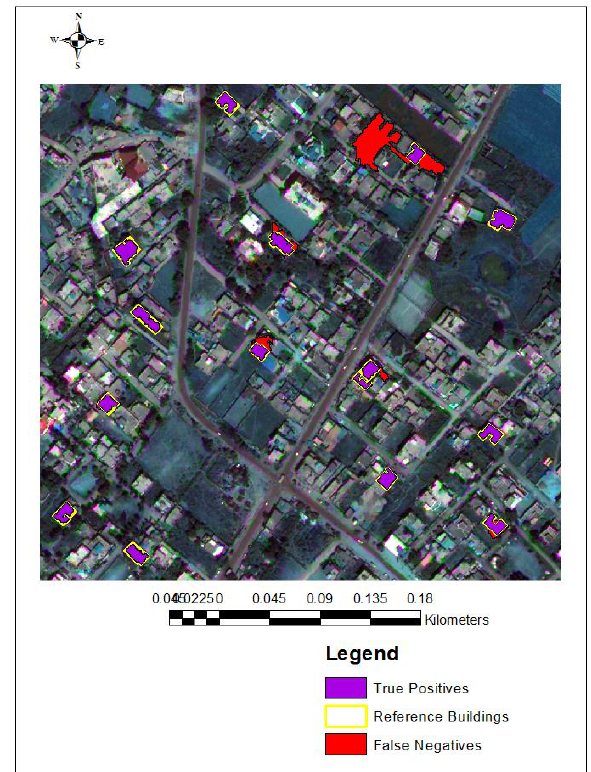
Figure 14 Accuracy assessment for Rule based feature extraction